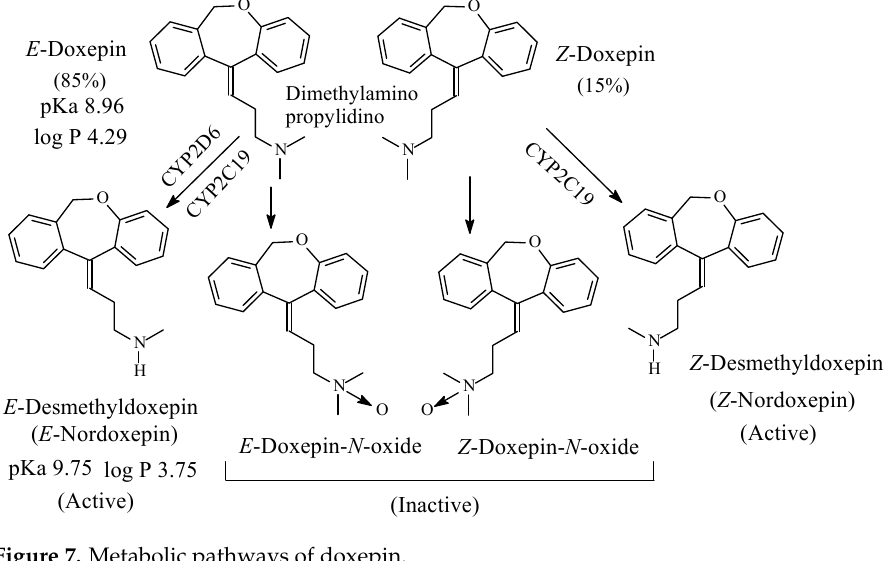
Figure 7. Metabolic pathways of doxepin.